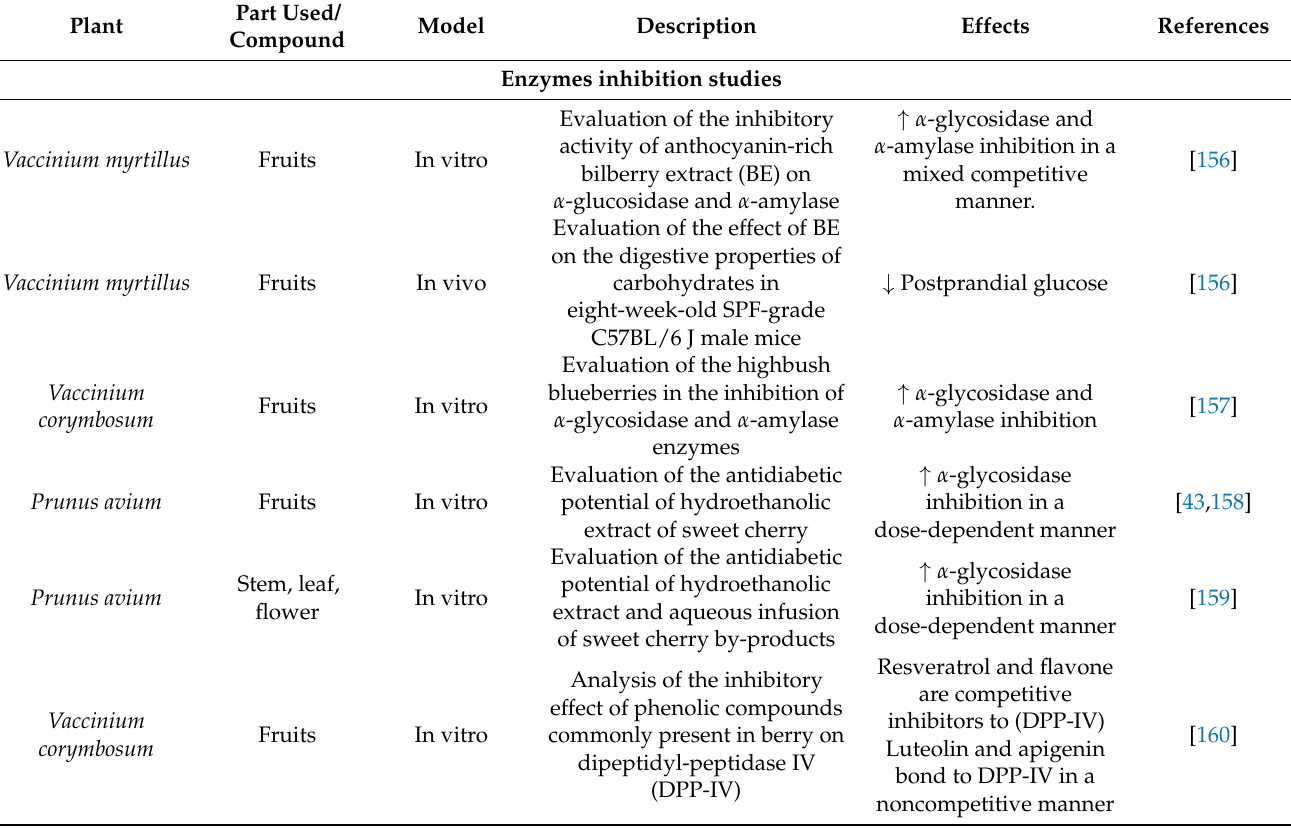
Table 7. Antidiabetic properties of cherries and